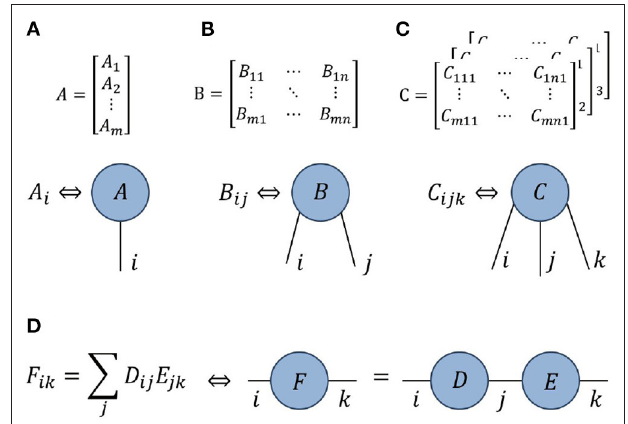
FIGURE 1 | (A–C) Diagrammatic representations of a vector A i (or order-1 tensor), a matrix B ij (or order-2 tensor) and an order-3 tensor C ijk . (D) A contraction, or summation over an index, between two tensors is represented by a line joining two